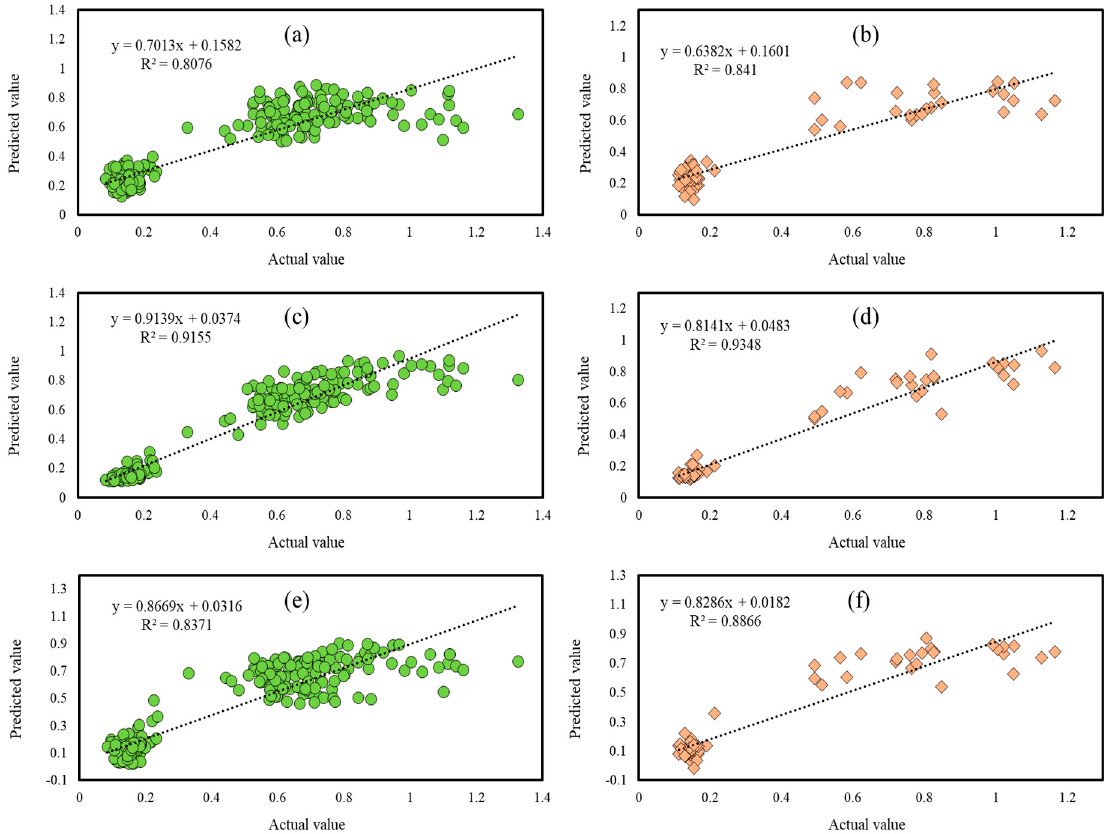
Figure 9. The correlation between the actual and predicted SSS in the training and testing phases of ( a , b ) ANN, ( c , d ) ALO–ANN, and ( e , f ) SHO–ANN.